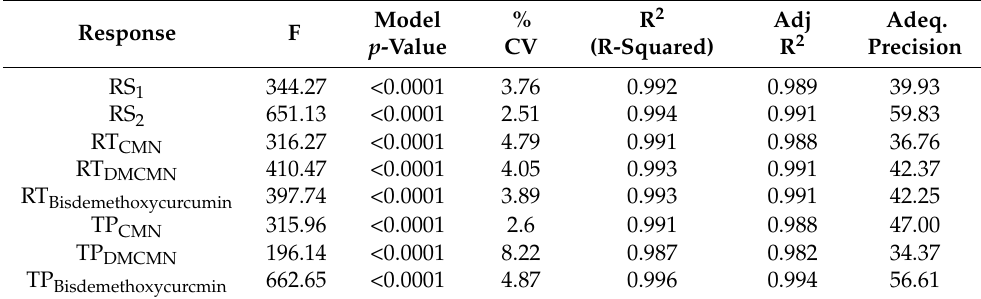
Table 2. The statistical summary of all the